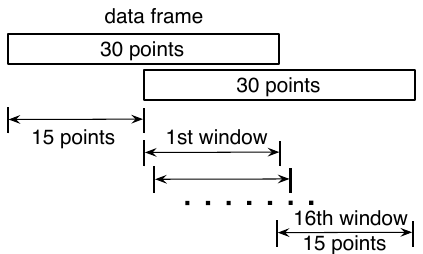
Figure 7. Data frame and window. The size of each data frame is 30 sampling points, and the size of each window is 15 sampling points. The overlap between two successive data frames is 15 sampling points.